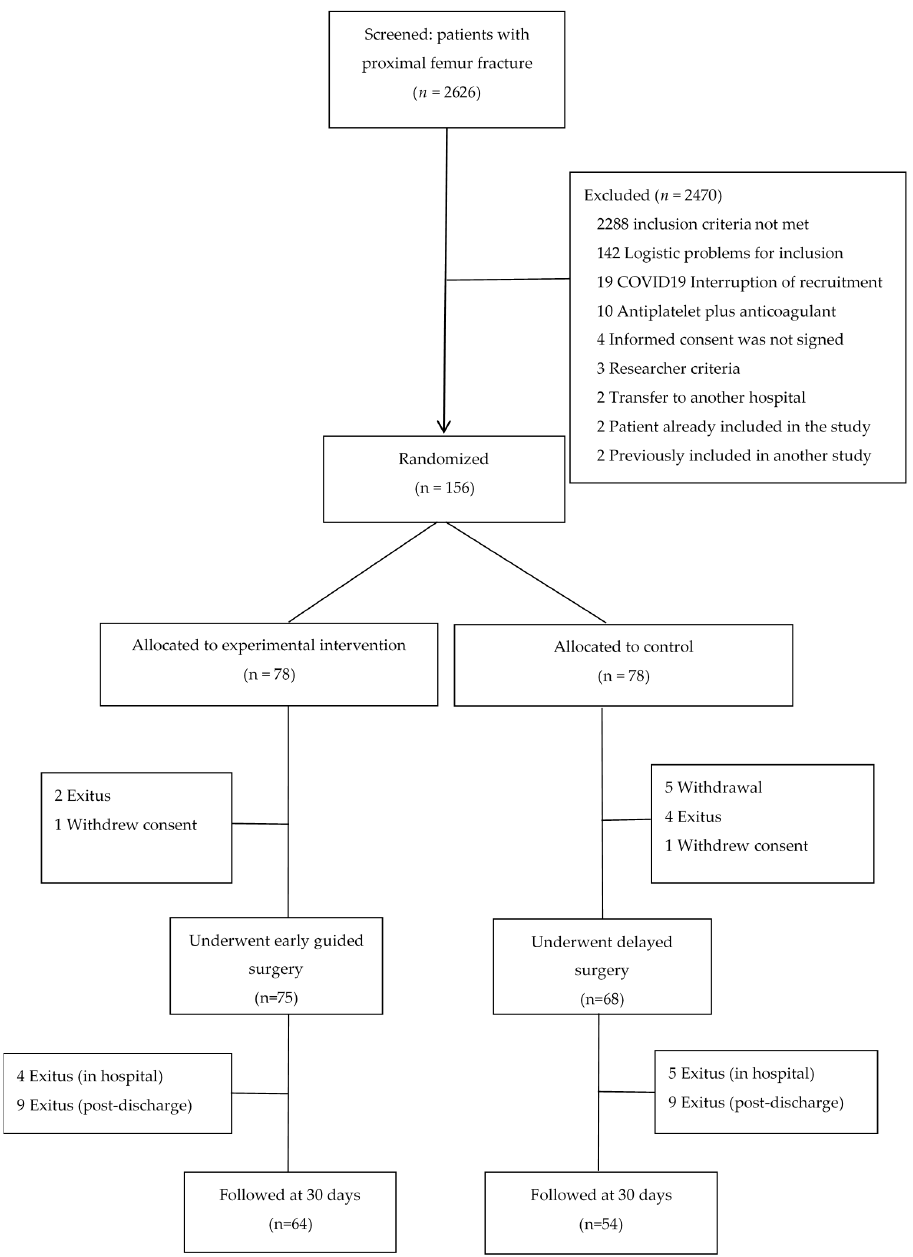
Figure 1. Flow chart of patients.